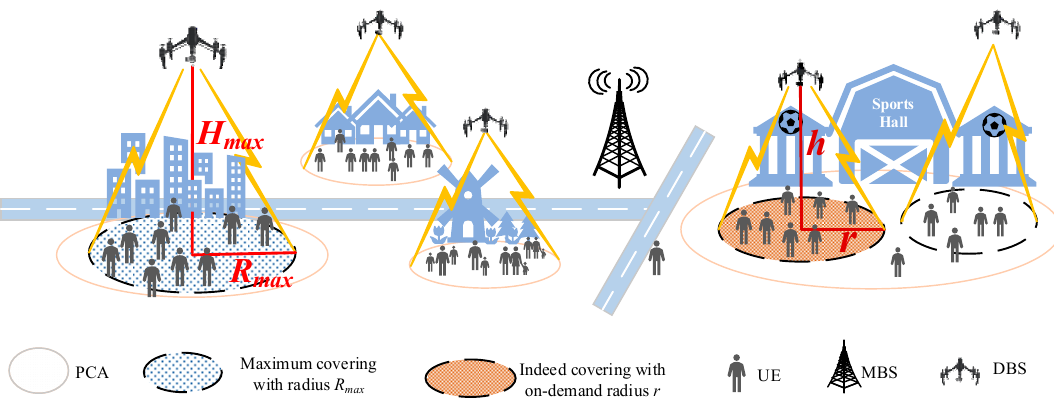
Figure 1. The deployment of multiple drone base stations (DBSs) in a drone-assisted wireless network. PCA: proactive coverage areas; UE: user equipment; MBS: macro base station.